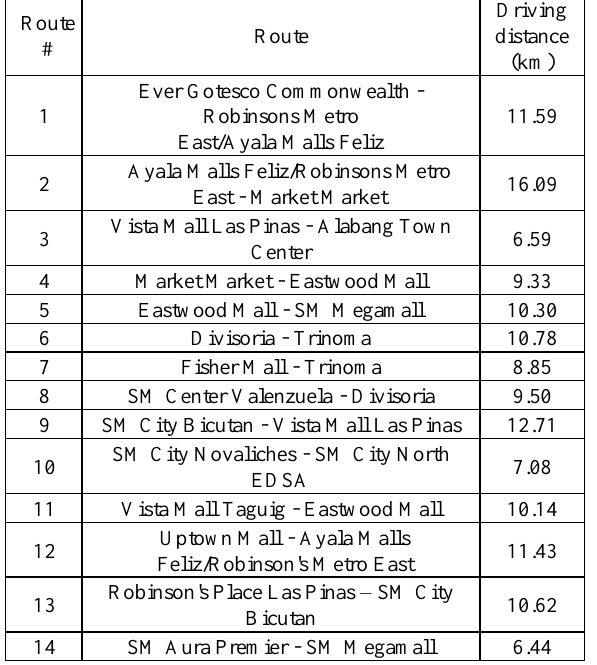
Table 5. Proposed P2P Premium Bus Service Routes Shown below is a sample map of the proposed new P2P Bus Routes: